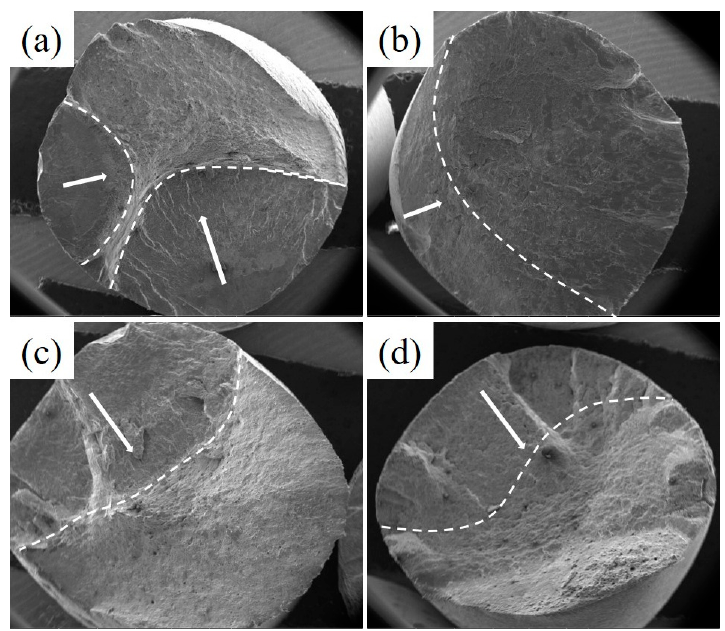
Figure 12. Overall morphologies of two materials, novel steel: ( a ) 0.2% and ( b ) 0.6%, and 30SiMn2MoV: ( c ) 0.2% and ( d ) 0.6%.